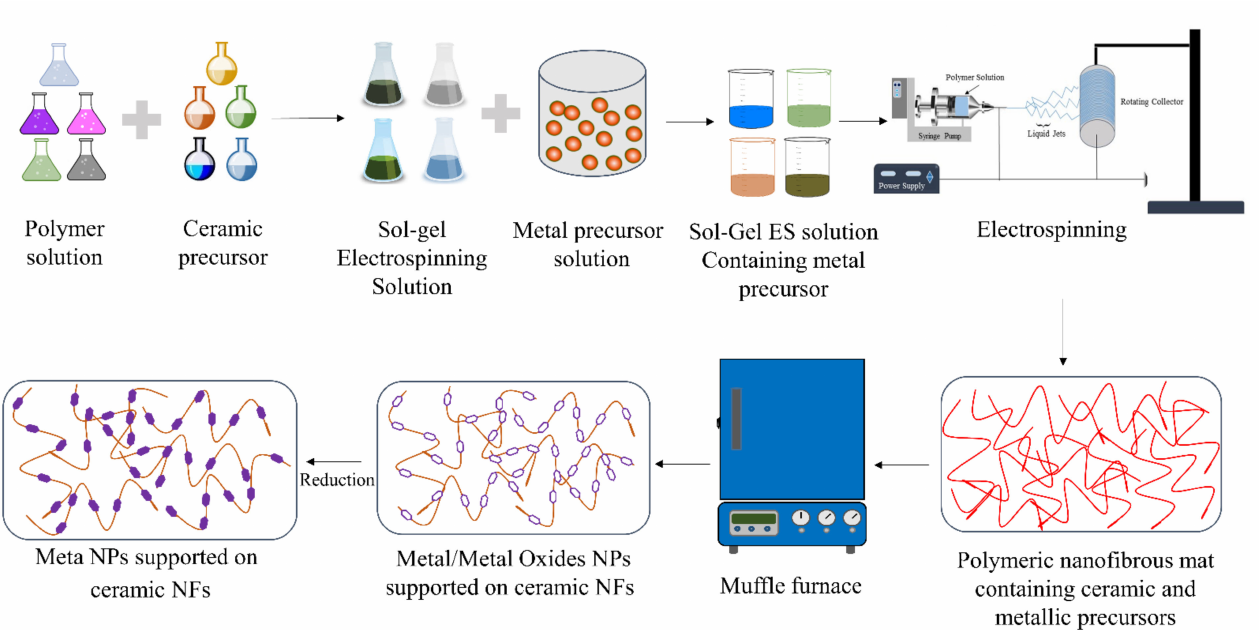
Figure 4. Preparation steps of supported ceramic nanofibrous catalysts using electrospinning followed by wet impregnation.